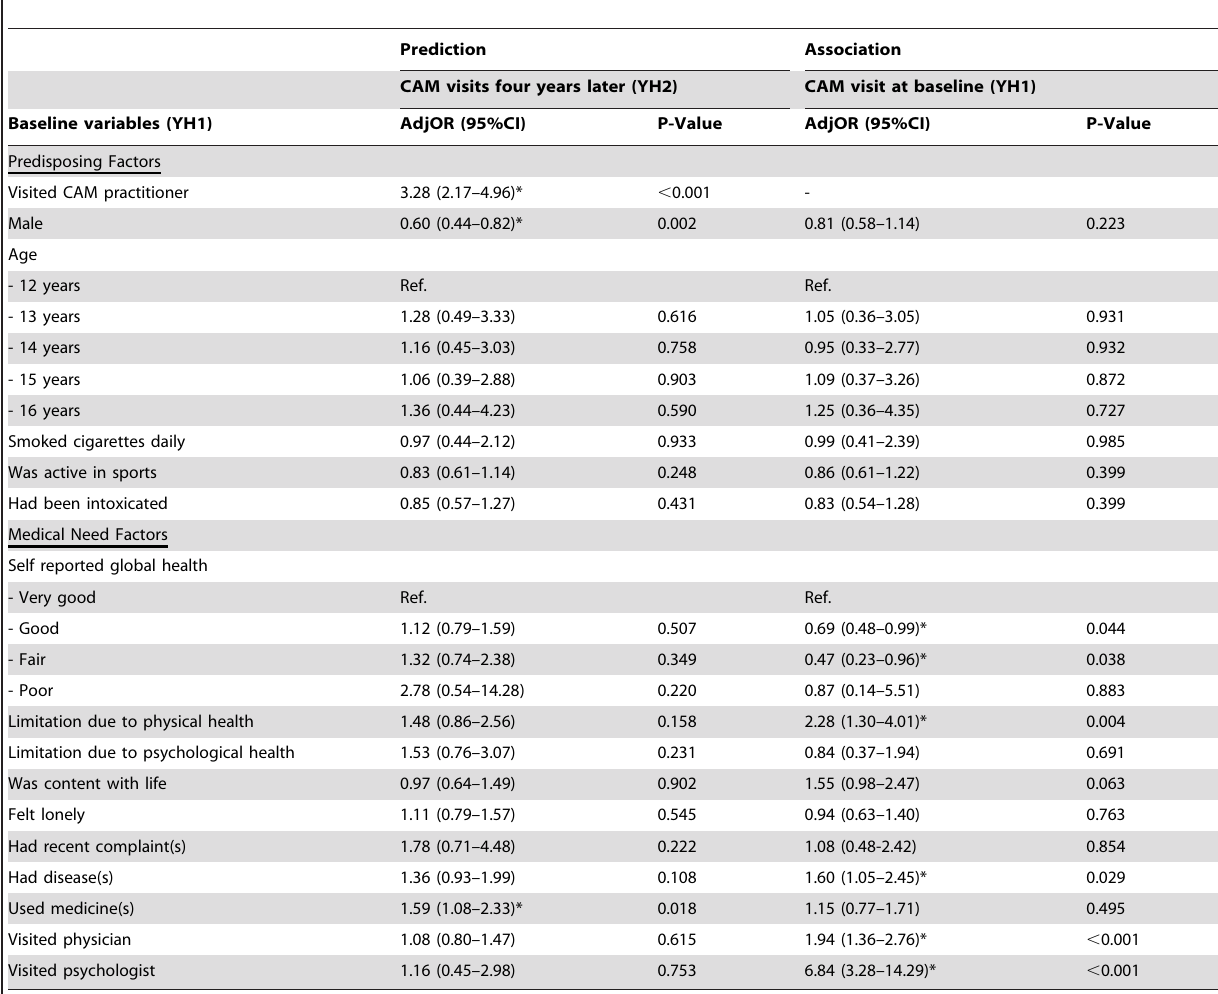
Table 2. Multivariable logistic regression models of baseline variables 1) predicting CAM visits four years later and 2) associated with CAM visits at baseline (N